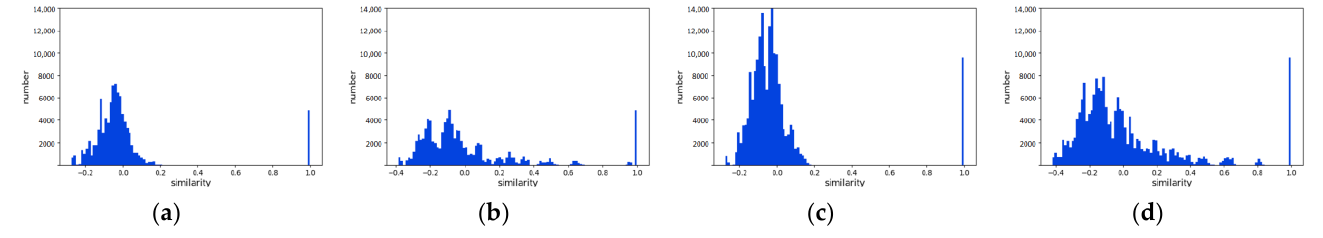
Figure 15. Distribution of similarity over the Chikusei dataset, when epoch = 300: ( a ) 𝑇 = 0.25, ℎ = 10; ( b ) 𝑇 = 1.0, ℎ = 10; ( c ) 𝑇 = 0.25, 𝑘 = 20; ( d ) 𝑇 = 1.0, ℎ = 20.